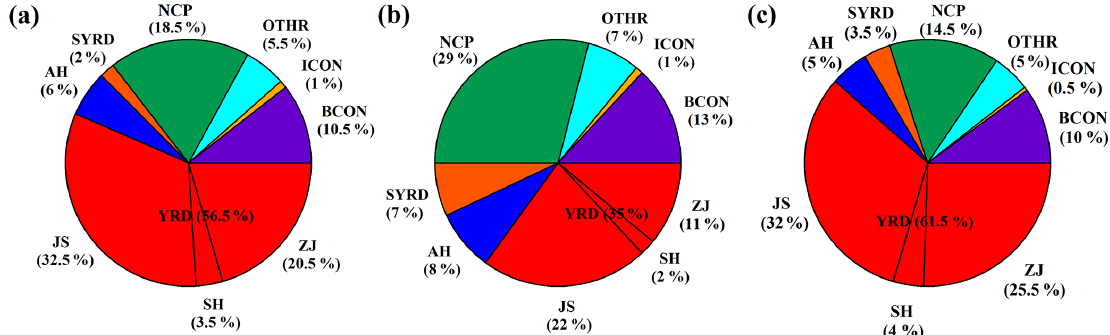
Figure 11. Contribution rate of each source region to PM 2 . 5 over the Yangtze River Delta (YRD) during (a) the whole simulation period, (b) the cold frontal passage, and (c) under the stable weather conditions. JS is Jiangsu, SH is Shanghai, and ZJ is Zhejiang.